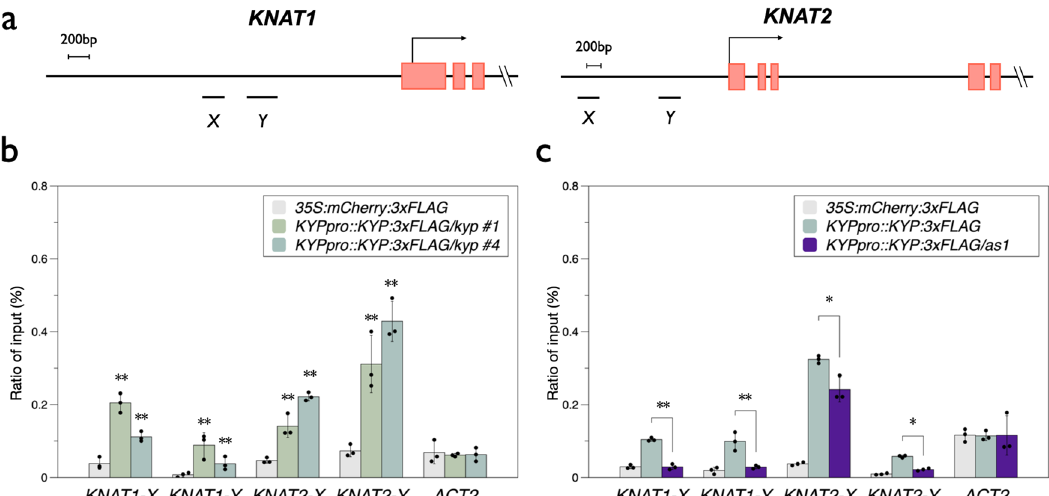
Fig. 4 Binding of KYP to KNAT1 and KNAT2 in vivo. a Schematic diagrams of KNAT1 and KNAT2 genomic sections. X and Y regions are the binding sites of AS1/2. b , c KYP binding to KNAT1 and KNAT2 promoters. 10 days-old seedlings grown under LD were harvested. ChIP assays were performed with the anti- FLAG antibody. The amount of immunoprecipitated DNA was quanti fi ed by qPCR. Values represent the normalized average immunoprecipitation ef fi ciencies (%) against the total input DNA. Error bars correspond to standard deviations from three biological replicates. * p < 0.05, ** p < 0.005 (Student ’ s t